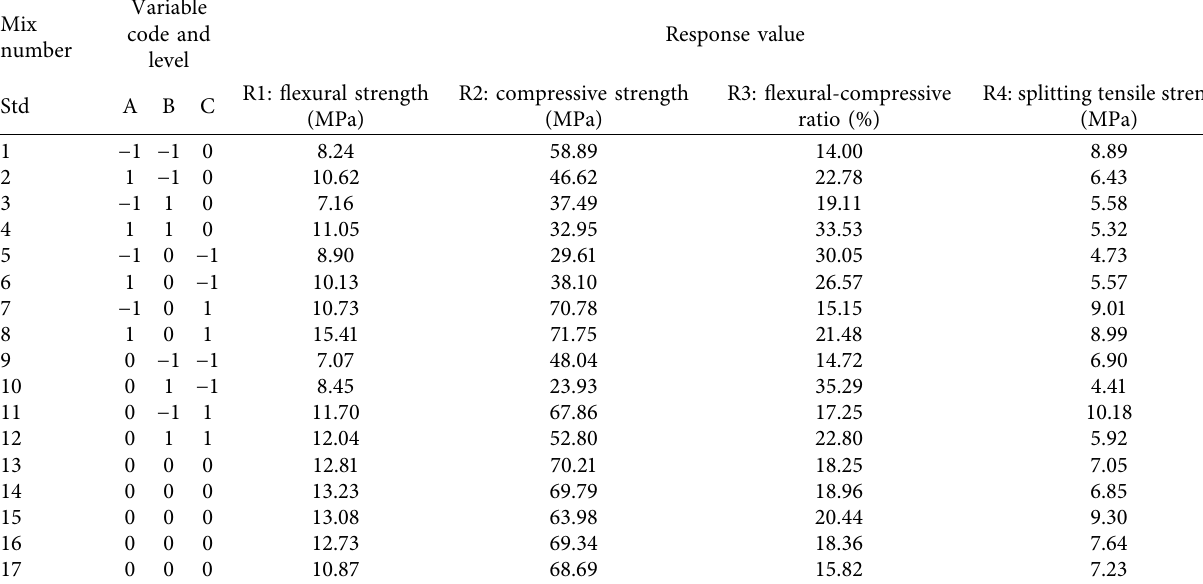
Table 4: Experimental factors and response results of BBD matrix